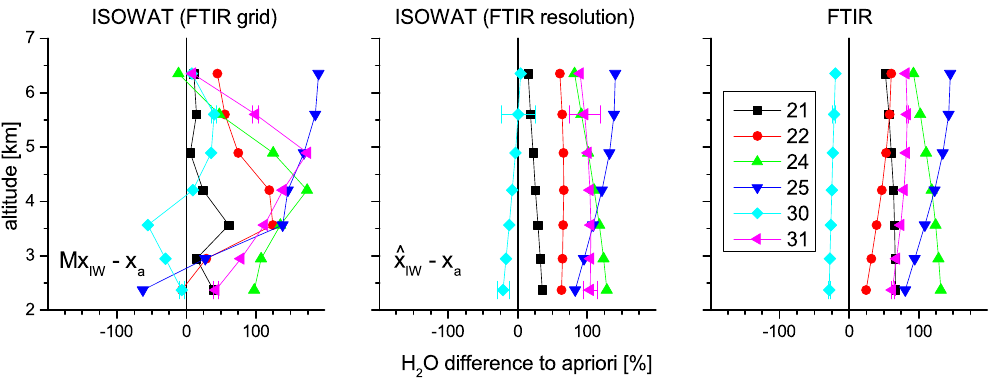
Figure 6. Comparison of ISOWAT and FTIR H 2 O measurements (one coincidence for each of the days 21, 22, 24, 25, 30, and 31 of July 2013). Shown are differences with respect to the a priori profiles. Left panel: ISOWAT data represented for the FTIR altitude grid; central panel: ISOWAT data convolved with the FTIR kernels, i.e. representative for the vertical resolution of the FTIR; right panel: FTIR data measured at the end of the morning when solar elevation is still < 30 ◦ . Depicted are also lower and middle tropospheric error bars for day 130730 (dry conditions) and 130731 (humid conditions), which are hardly discernible, since the H 2 O errors are only a few